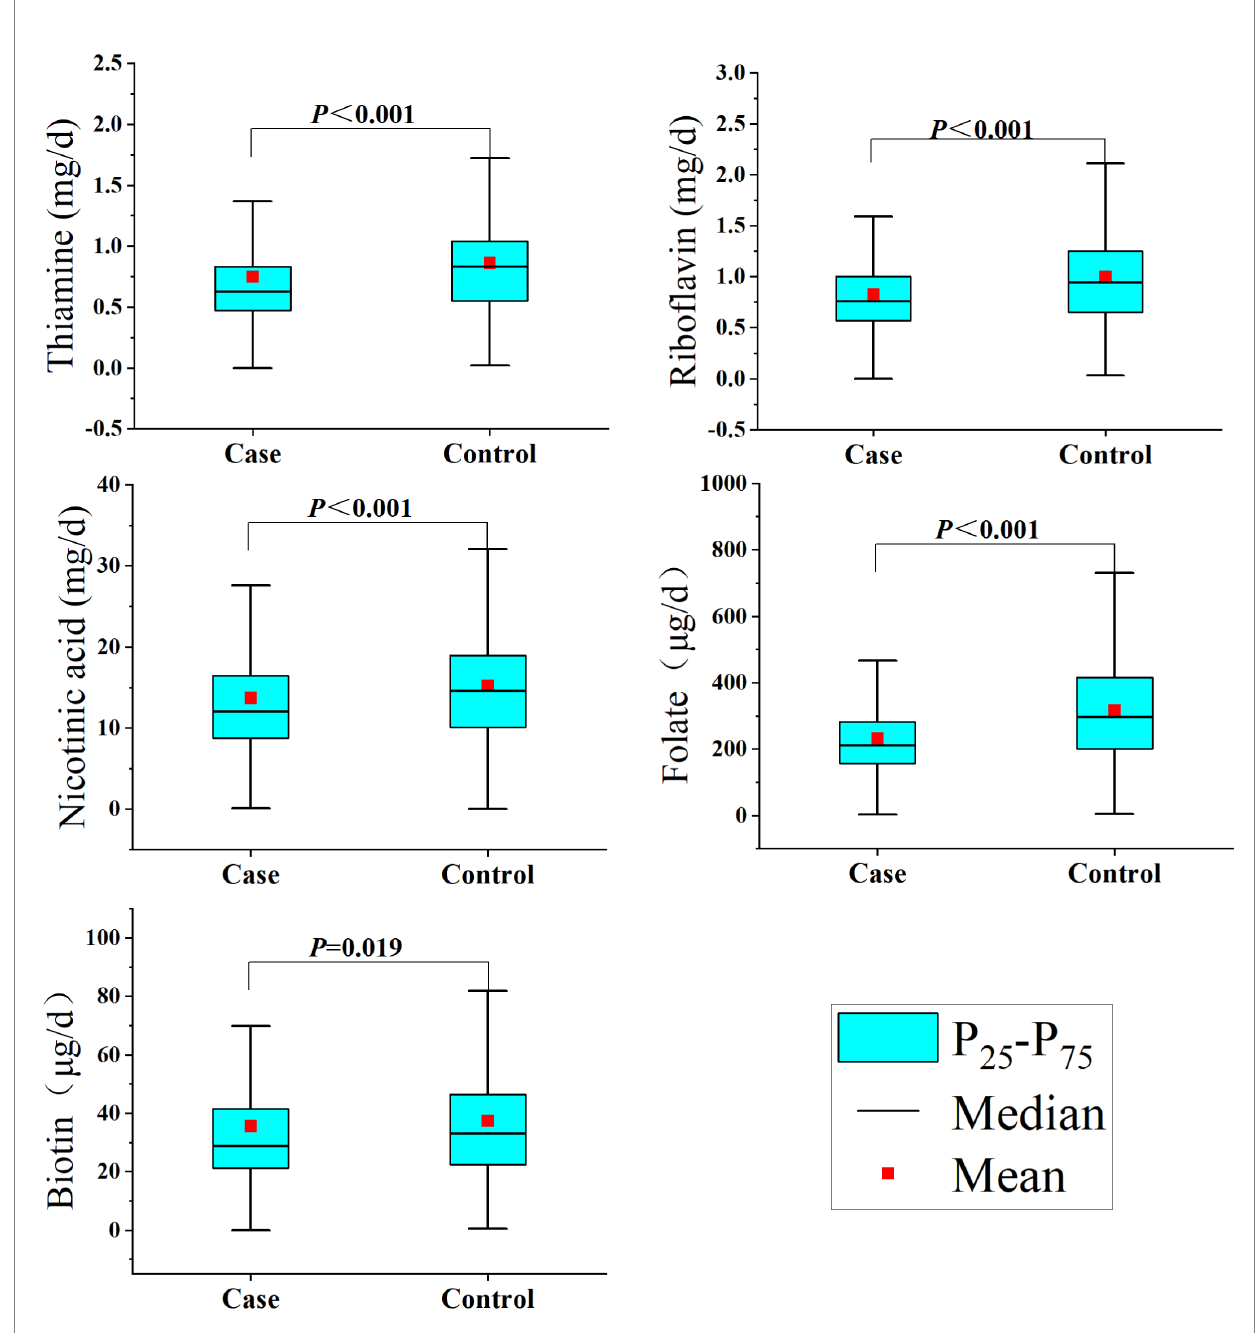
FIGURE 1 B vitamins intake among study